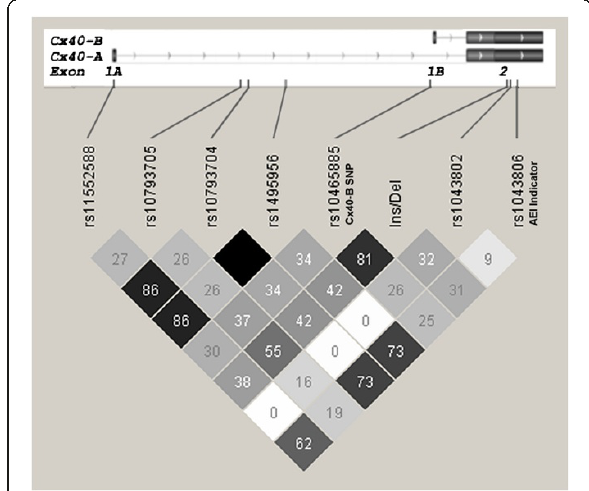
Figure 3 Linkage disequilibrium of the GJA5 3 0 UTR insertion/ deletion. Linkage disequilibrium relationships (r 2 ) between the Cx40 - B promoter SNP (rs10465885), a Cx40 - A promoter SNP (rs11552588), the 3 0 UTR SNP (rs1043806) used for the allelic expression imbalance assay, the insertion deletion polymorphism (Ins/Del), and four other GJA5 SNPs from the Illumina Hap550 BeadChip. The positions of the SNPs relative to the alternative transcripts for Cx40 - A and Cx40 - B are displayed. The D 0 between rs1043806 and the insertion/deletion is 1.0 (not